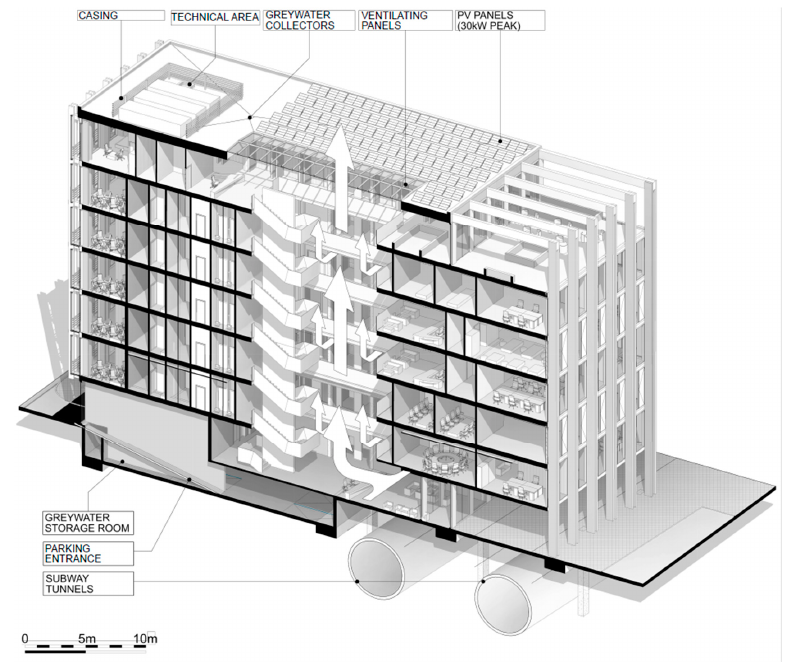
Figure 8. A 3D cross section through the aerating elevation proposed for north and east exposures.